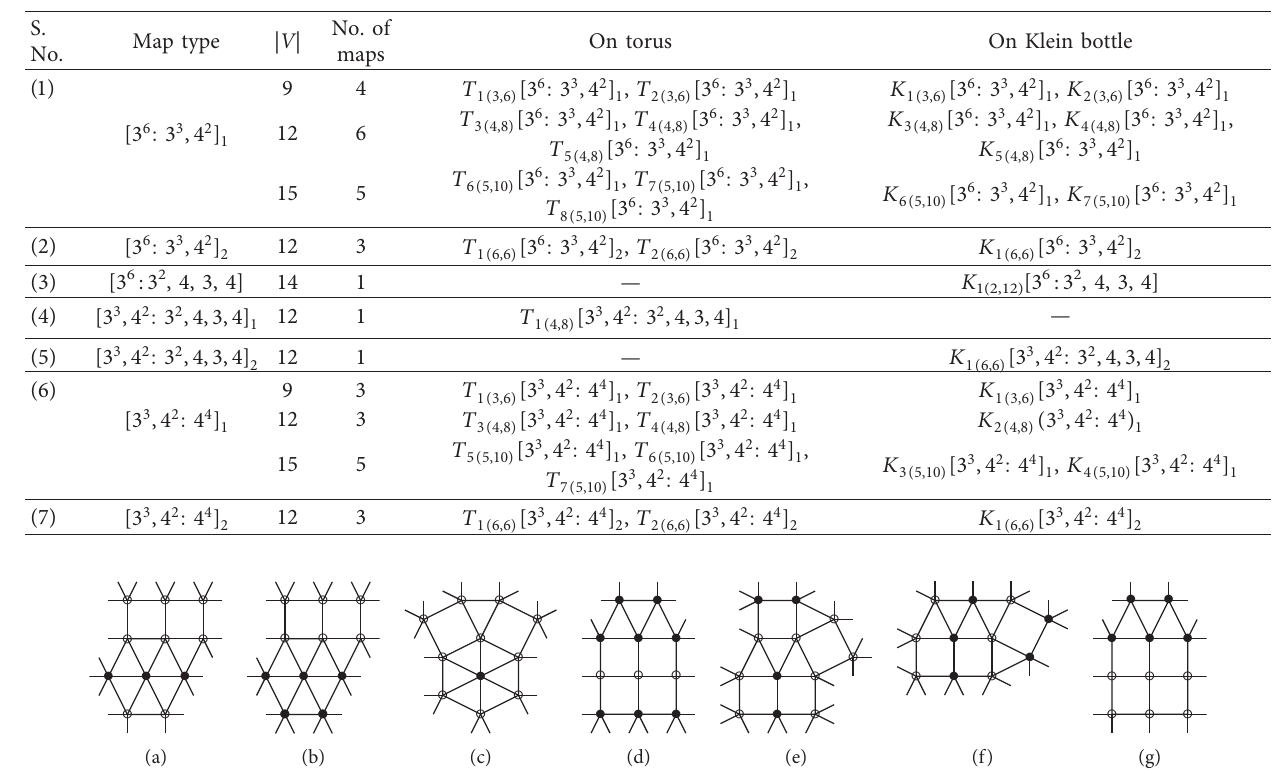
Table 1: DSEMs of face-size 4 on torus and Klein bottle on ≤ 15